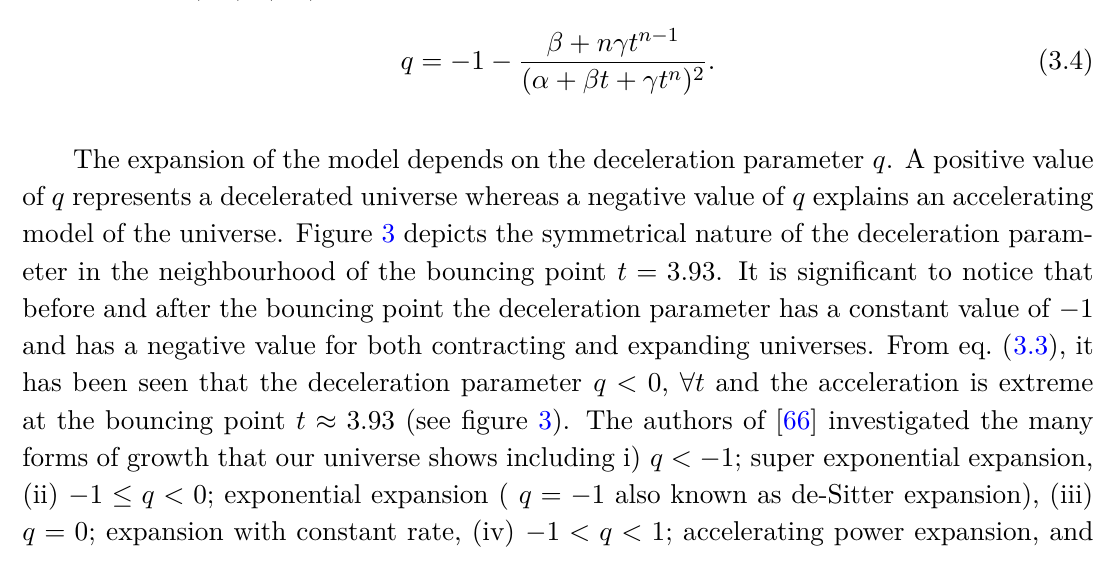
table 1 for the different values of model parameters β and γ and fixed values of n and α